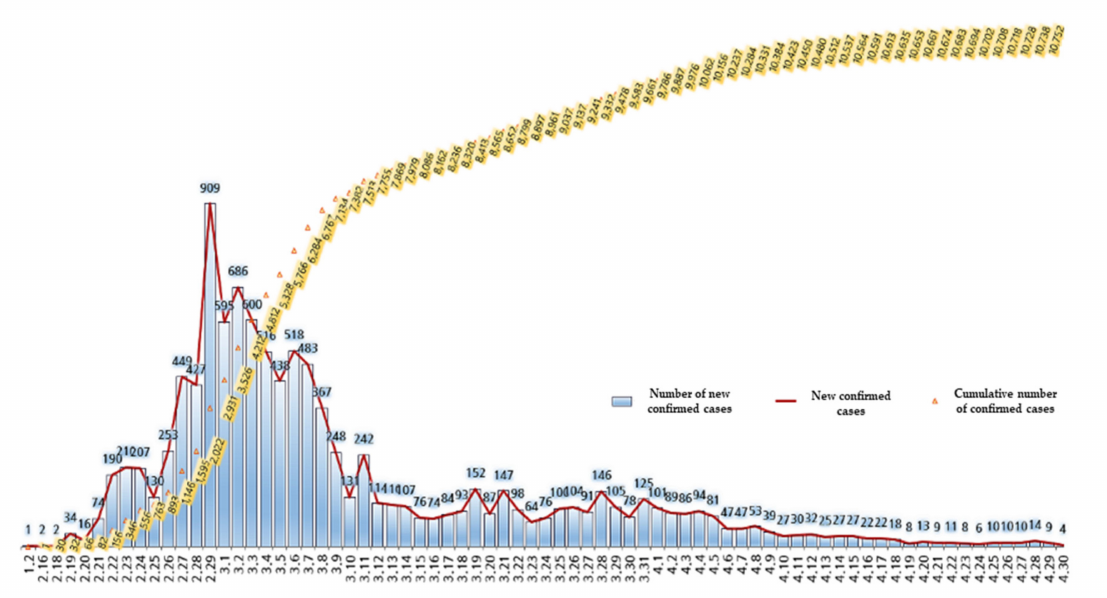
Figure 1. Daily status of new and cumulative confirmed cases in